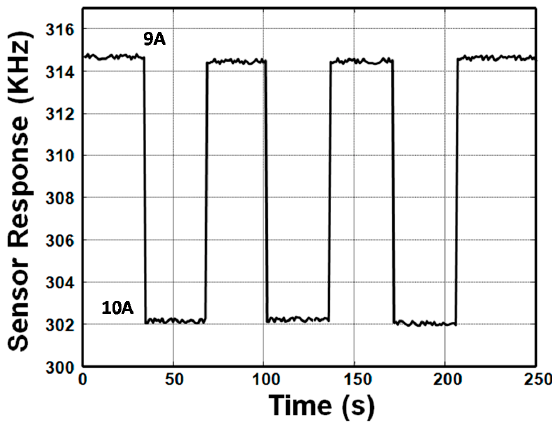
Figure 14. The repeatability test of the developed SAW sensor.